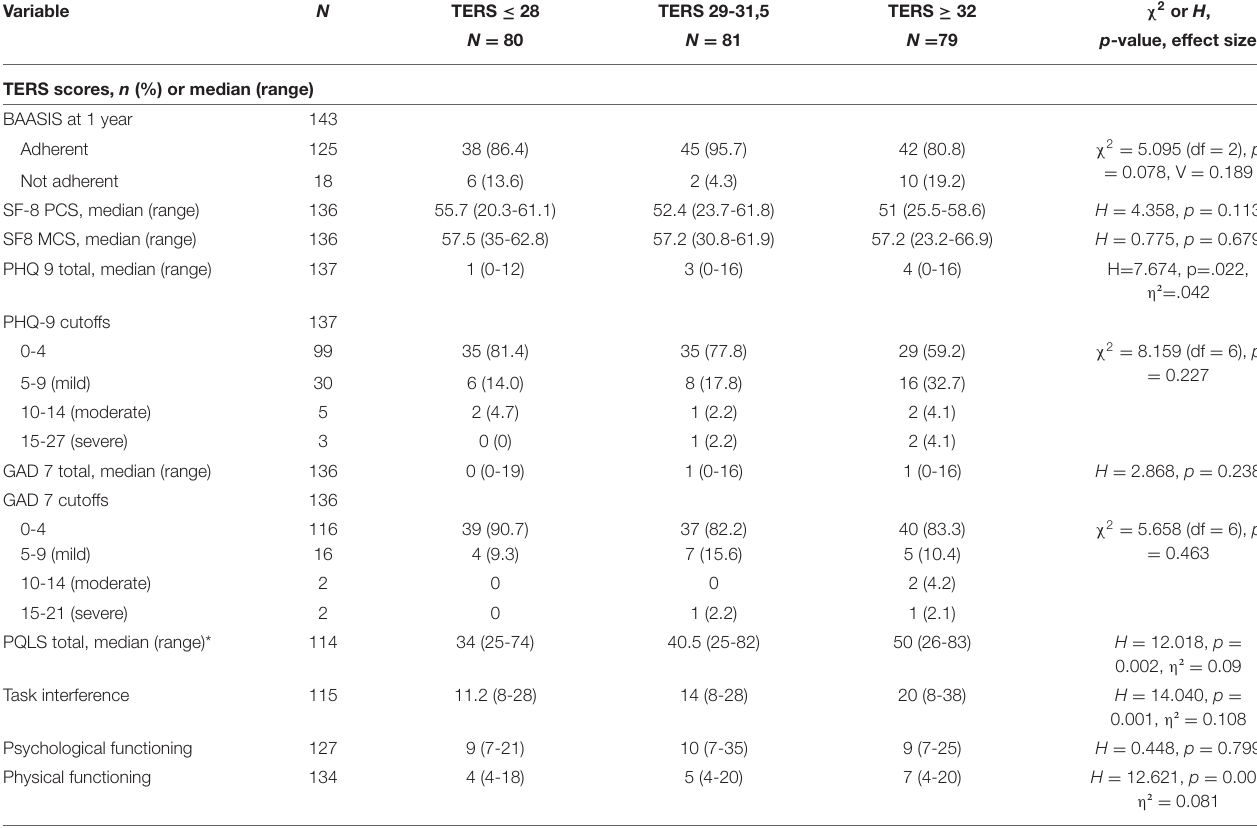
TABLE 6 | Comparison of extended 1-year post-transplant outcomes according to TERS tertiles ( n = 143). Variable N